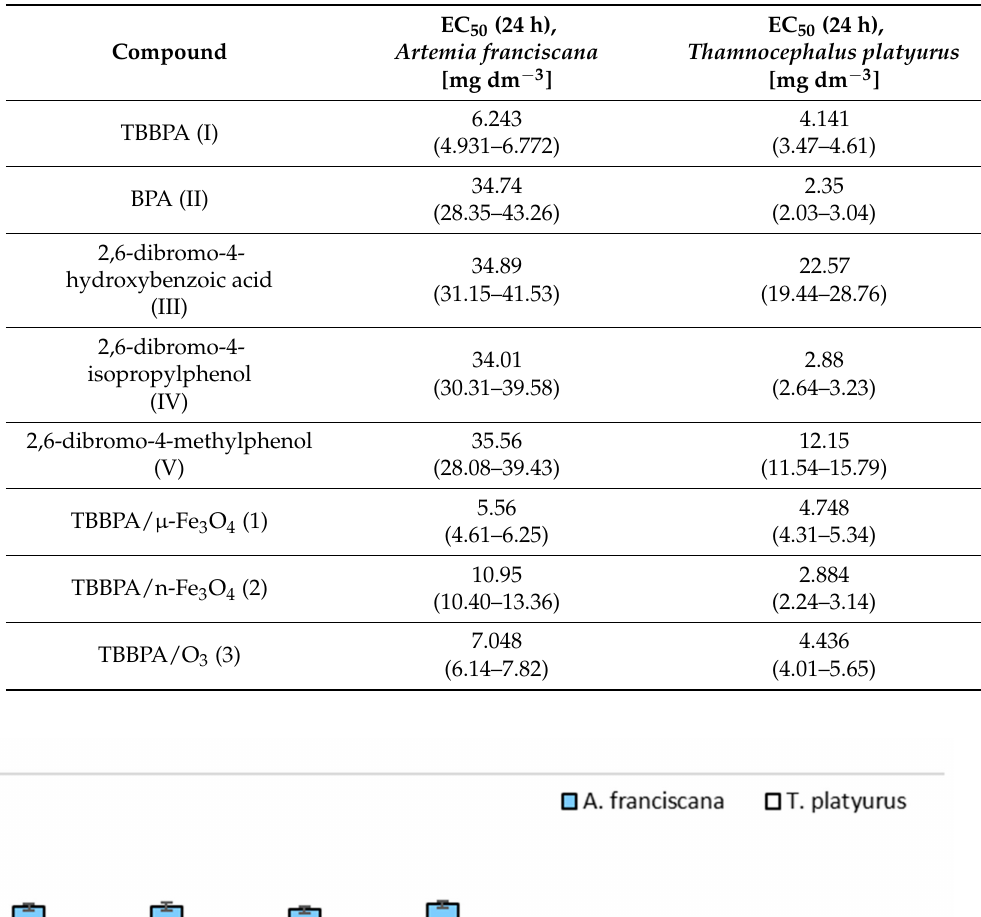
Table 2. EC 50 levels of tested compounds.